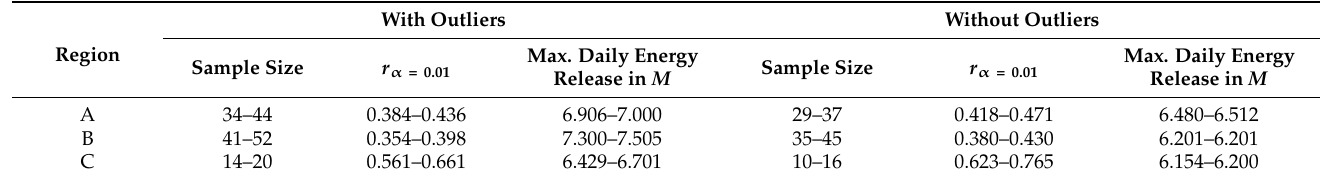
Table 2. Parameters for daily energy release equivalent to M ≥ 5.5